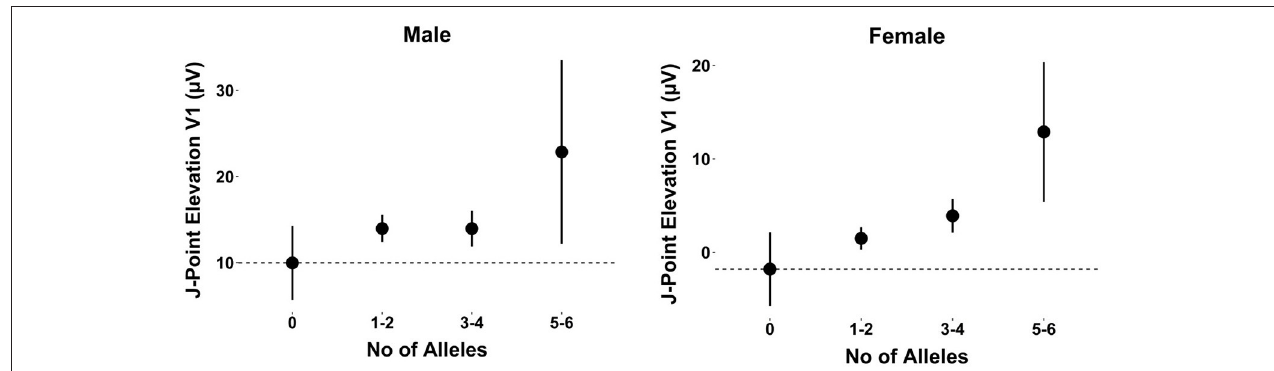
Frontiers in Physiology |